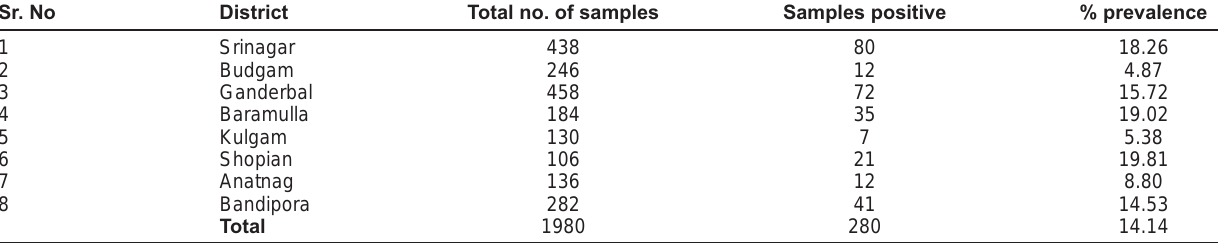
Table-2. Brucellosis results of organized farms (April 2010-April 2012) Sr.